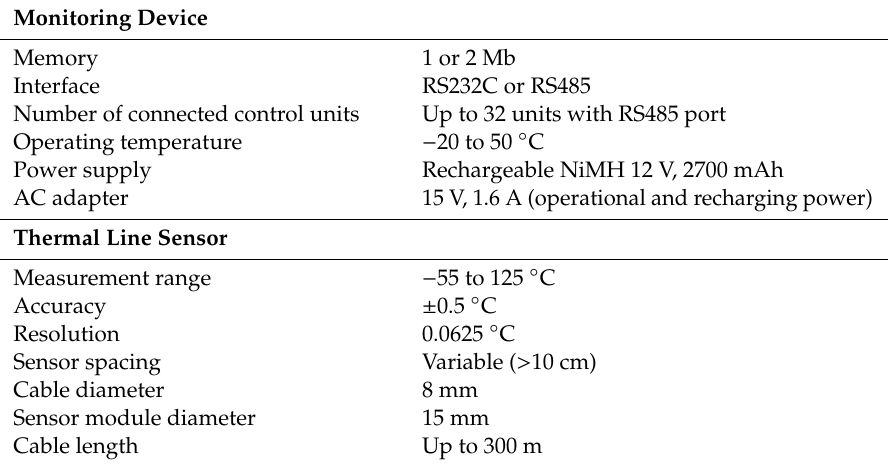
Table 3. Technical specifications of borehole temperature monitoring